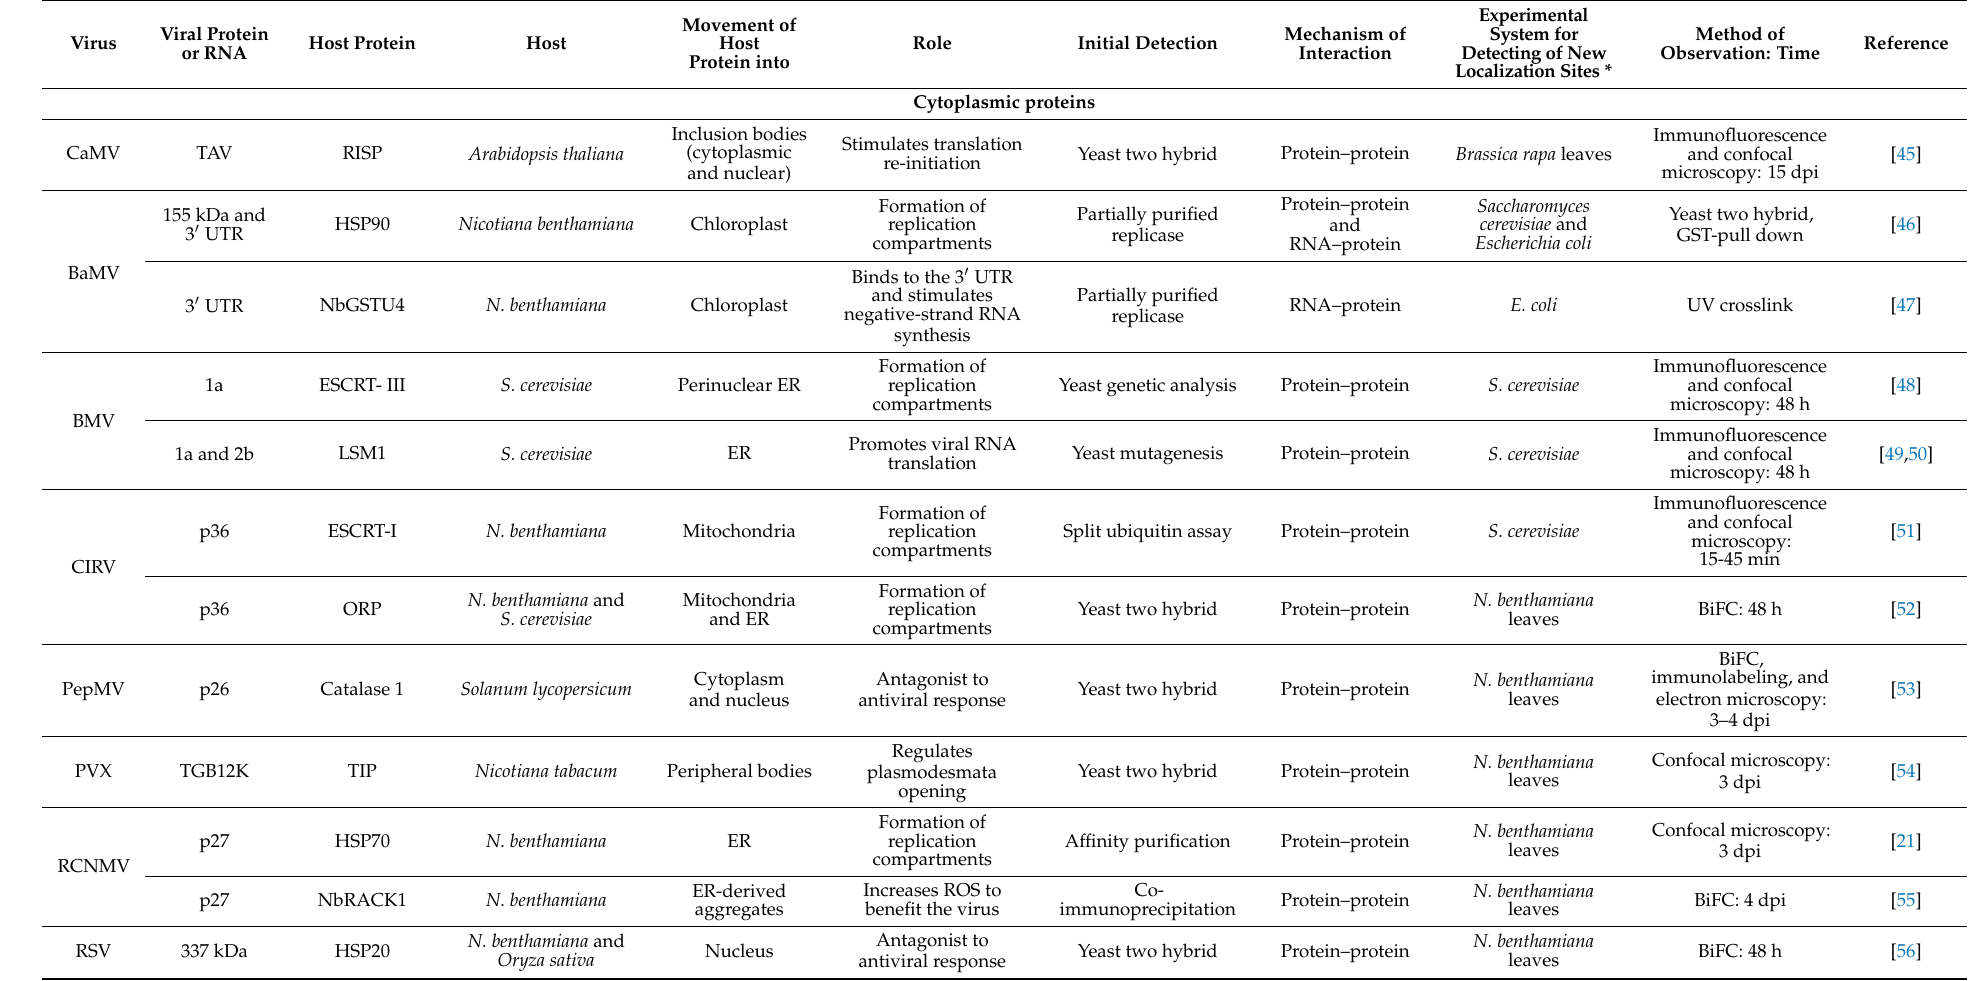
Table 2. Host proteins that participate in essential viral processes and that change subcellular localization during viral infection. Host proteins are organized based on their natural distribution in the absence of